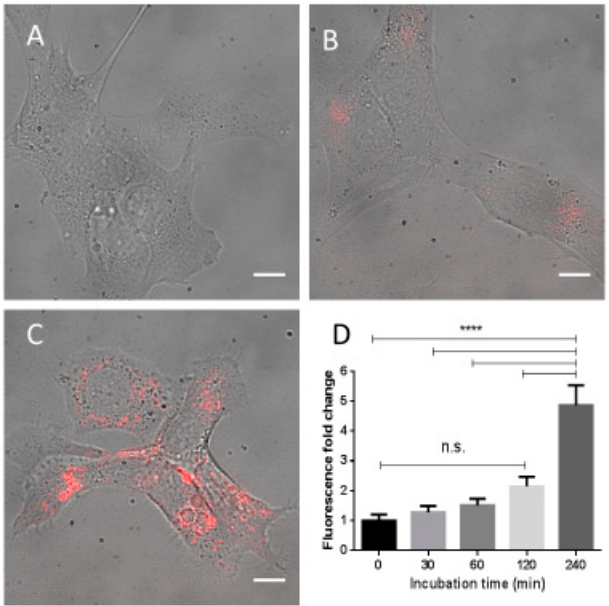
Figure 2. Human hepatocarcinoma (HepG2) cells incubated with 90 µ g/mL Fe 3 O 4 -nanoparticles conjugated with fluorescent dye Dylight650. The images of treated cells at selected incubation times are shown: 0 min ( A ); 120 min ( B ); and 240 min ( C ). The increments in fluorescence intensity at each incubation times, mean ± standard error (SE), are reported in the insert ( D ). Scale bar: 10 µ m; **** p < 0.0001; n.s. = not significant.